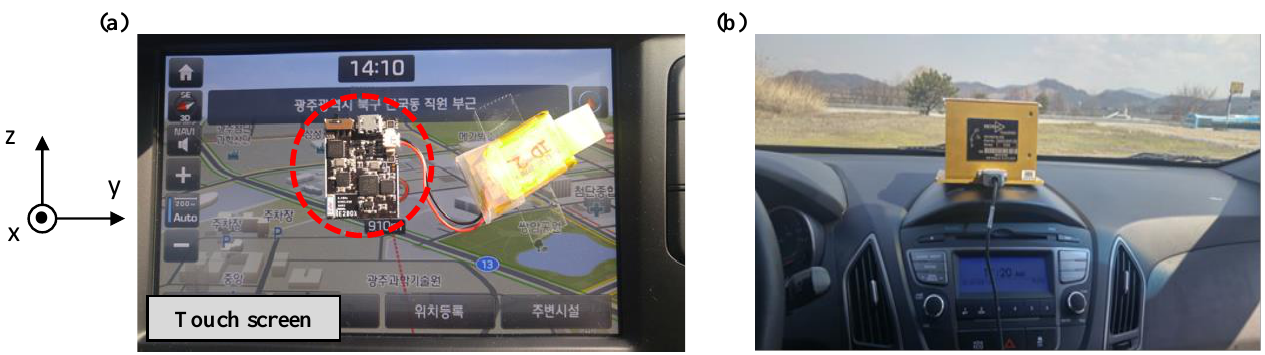
Figure 3. Measuring setup of driving vibration on the touch screen in vehicles. ( a ) E2BOX’s EBIMU24GV3. ( b ) Crossbow’s